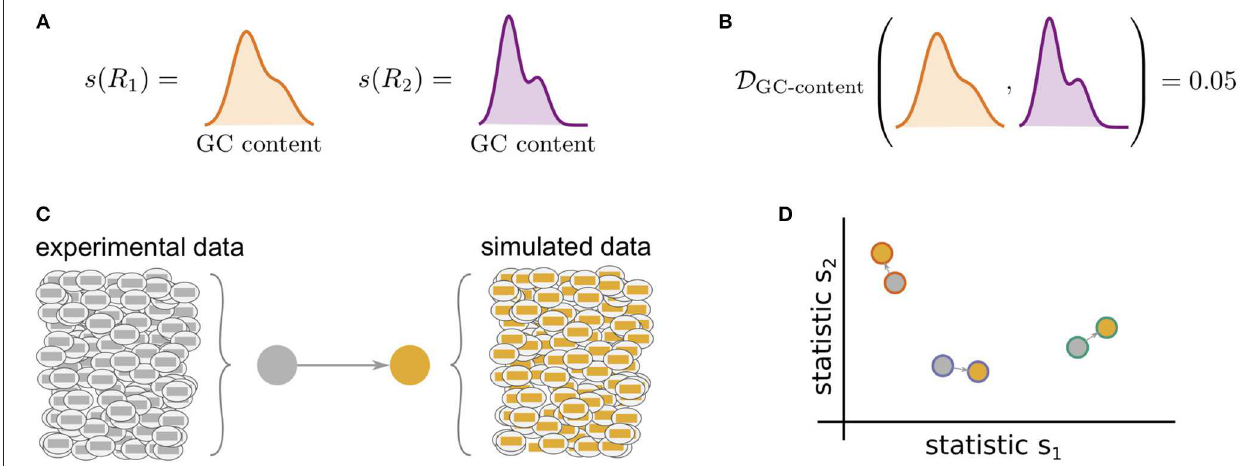
FIGURE 1 | Cartoon of our summary statistic and divergence framework, and how this can be applied to validation of repertoire simulators. Steps (A,B) can be applied to compare arbitrary datasets, while (C,D) show how sumrep can be used for model validation. (A) Most summary statistics s , e.g., GC content, yield a distribution of values when applied to each of the sequences in a given repertoire R . (B) We can compare summary distributions using a statistical divergence D , which takes two distributions and outputs a nonnegative scalar. (C) For a given experimental dataset, we use simulator tools to generate a corresponding set of synthetic sequences. (D) We can compute many summaries of these repertoires yielding distributions for